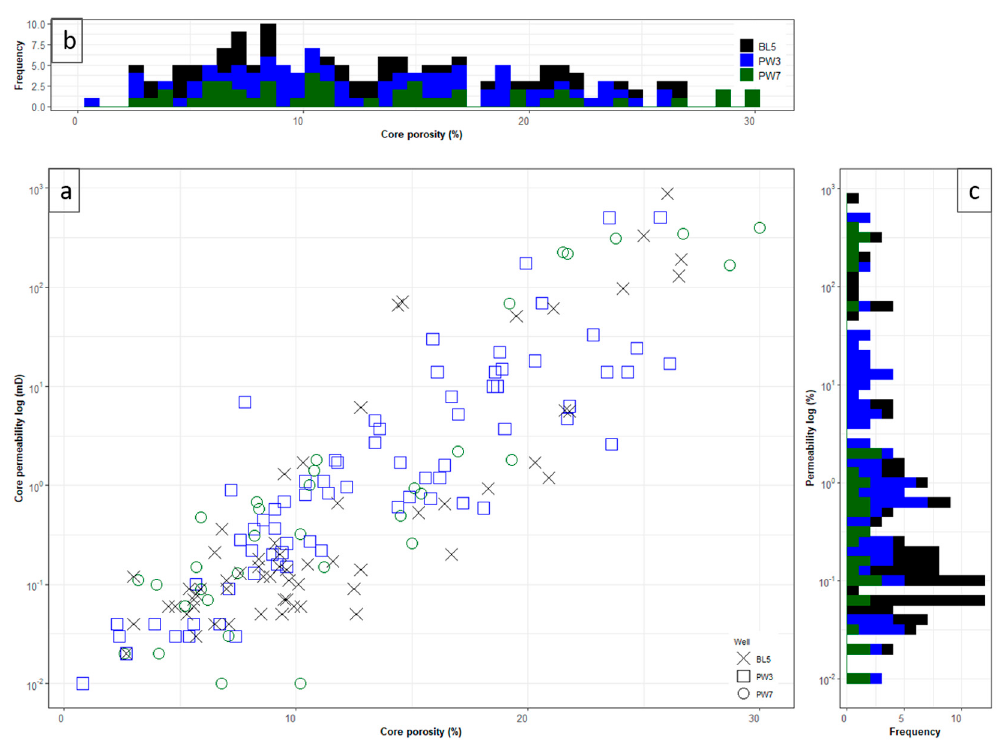
Figure 5. Show a scatter plot with porosity vs. permeability on a scatter plot ( a ). Margins of the scatter plot shows histograms of porosity ( b ) and permeability ( c ). The scatter plots show good porosity and permeability relationship with permeability spread locally over two orders of magnitude suggesting other controls on permeability apart from porosity.